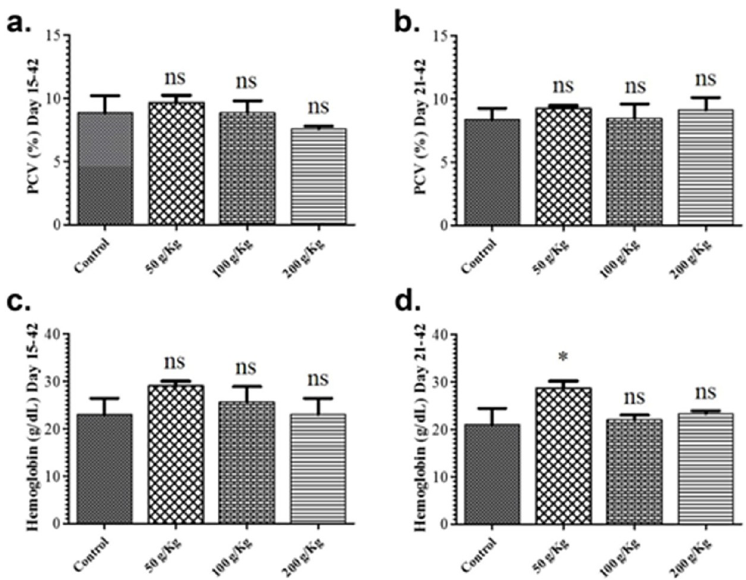
Fig 3. Graphs show the comparison of hematological parameters of different quinoa enriched diet given chicken groups fed from days 15 to 42 as well as from days 21 to 42 post-birth. The chickens were given 50 g/Kg, 100 g/Kg and 200 g/Kg of quinoa. ( a ). Packed cell volume (PCV) levels of chicken treated from days 15–42 ( b ). PCV levels of chicken treated from days 21–42 ( c ). Hemoglobin levels of chicken treated from days 15–42 ( d ). Hemoglobin levels of chicken treated from days 21–42. All data are expressed as means ± standard deviation (SD) from measurements on 15 chickens. � p � 0.05 in all quinoa supplemented diet fed groups versus the commercially available diet without quinoa fed control group. Note : ns means not